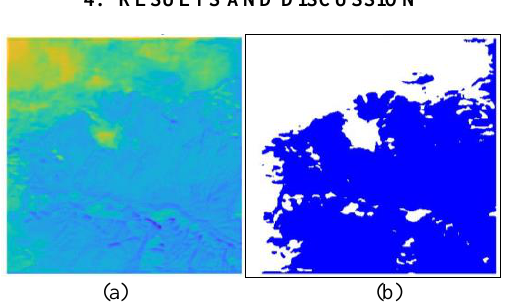
Figure 5. (a) Confidence Map of test tile: yellow pixels have been classified with highest probability (1), and shades of blue have the lowest probability (0); (b) class map of test tile: blue represents snow and white represents clouds